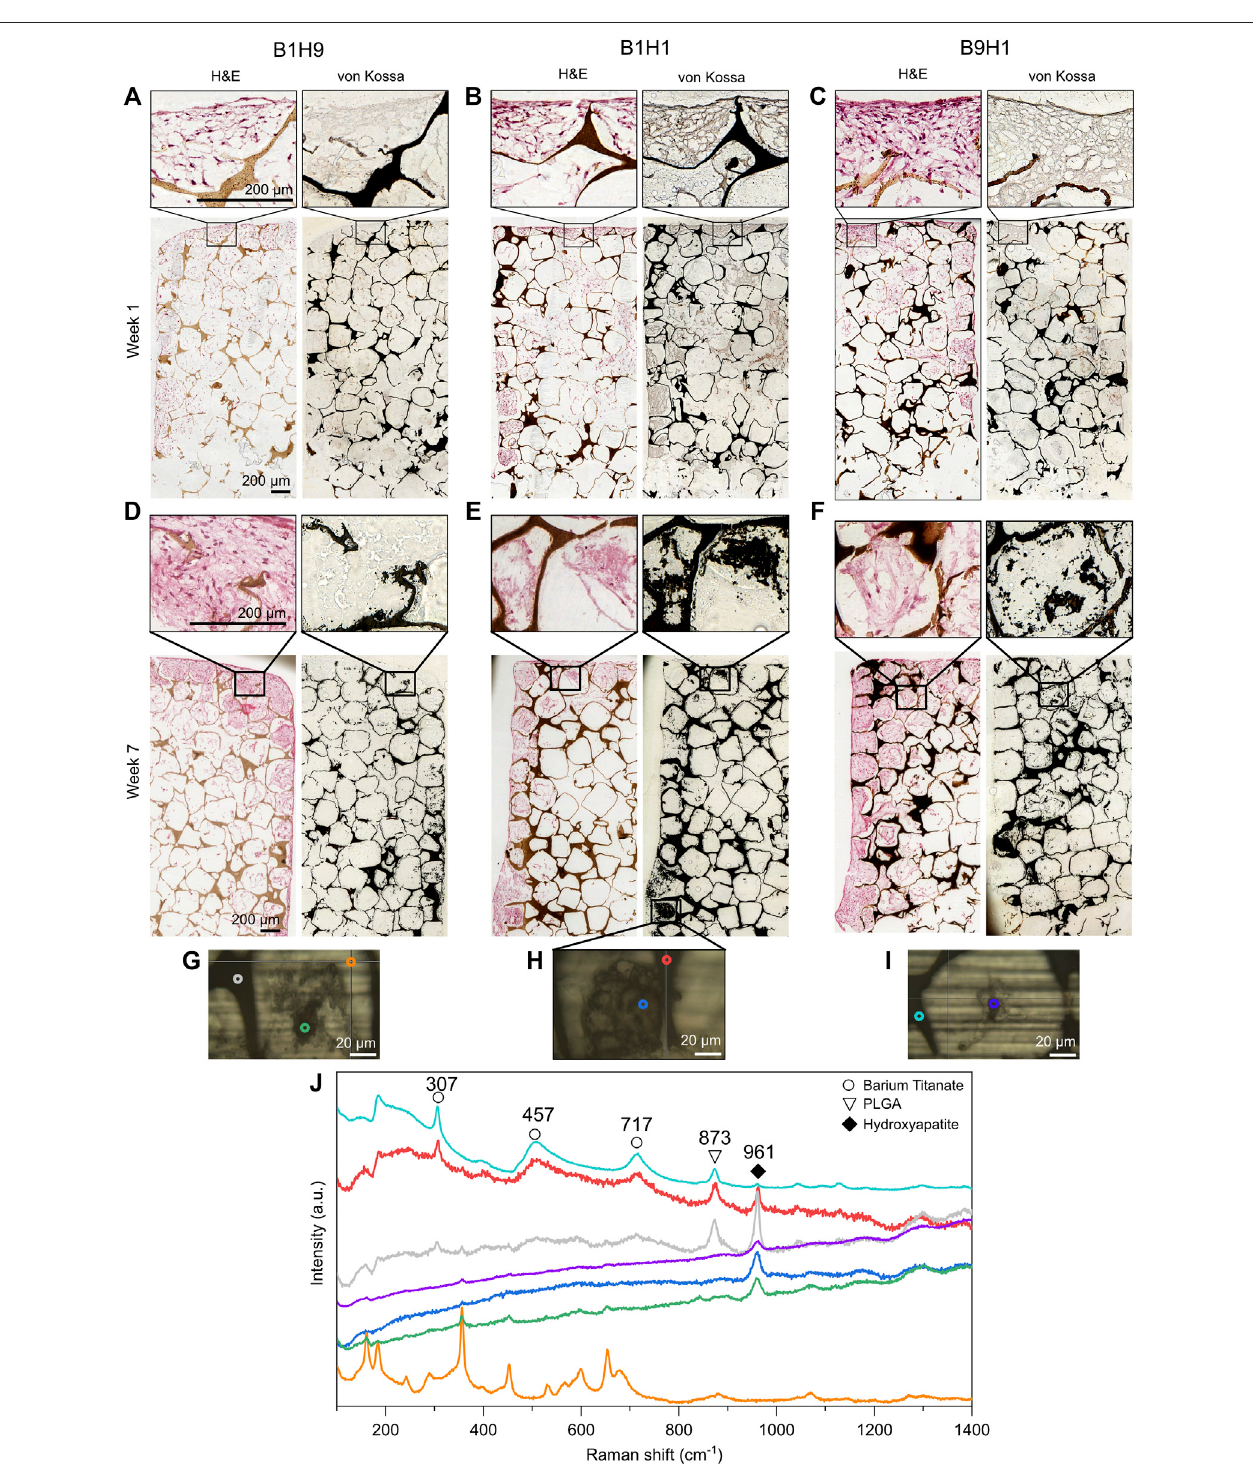
FIGURE 2 | Static cell culture of nanocomposite scaffolds. (A-C) Hematoxylin and eosin staining (H&E) and von Kossa staining of B1H9, B1H1, and B9H1 nanocomposite scaffolds after 1 week and (D-F) 7 weeks. (G-I) Micrographs of the location of Raman spectra measurements and (J) the corresponding Raman spectra; the colors of the spectra correspond to the different regions in (G – I) . The circle indicates vibration bands from barium titanate, the triangle marks the characteristic vibration band of the polymer PLGA, and the diamond highlights the characteristic peak of hydroxyapatite. The orange spectrum taken in the background corresponds to the Kawamoto tape used for sectioning. N = 2 samples were sectioned for each group.